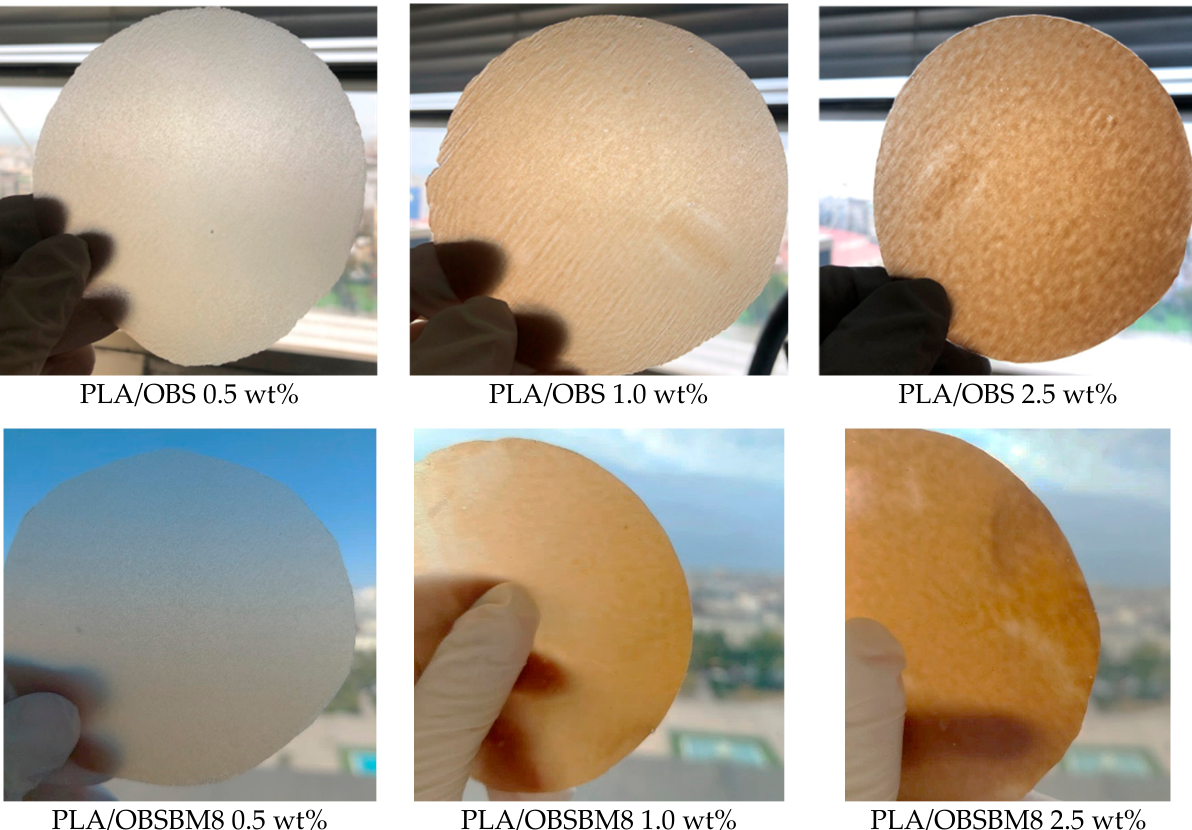
Figure 2. Photographs of the PLA/lignin films.